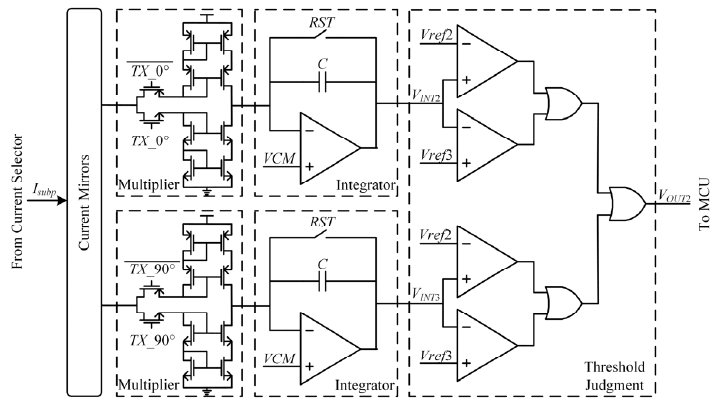
Figure 7. The scheme of the proposed cross-correlation circuit and threshold judgment circuit in the TX judgment circuit.